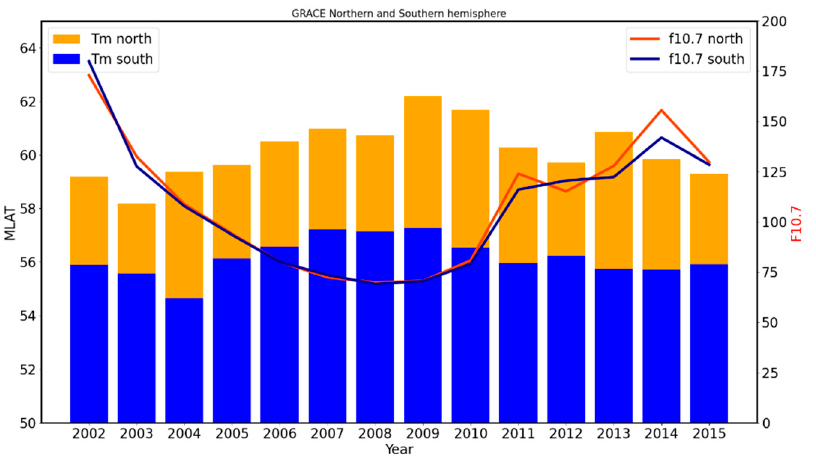
Figure 7. Solar cycle variation in trough minimum location from 2002 to 2015 for the northern and southern hemispheres.